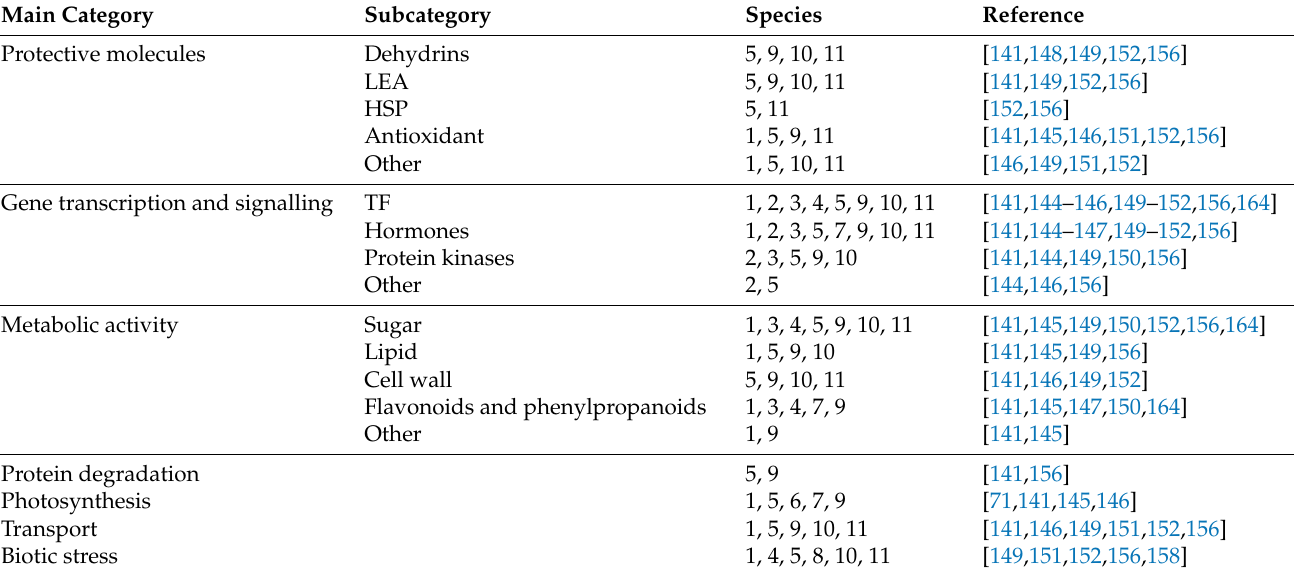
Table 2. Main categories of genes related to drought responses in conifers. Main Category Subcategory